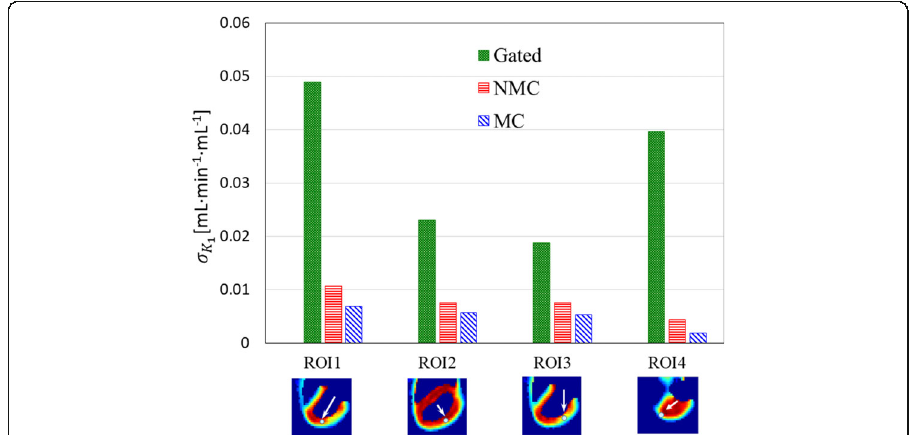
Fig. 8 Standard deviation of K 1 values estimated from 25 noise realizations. Each white arrow together with a small circle were only used to indicate the approximate location of the ROI. Please see the text in the “ Methods ” section for the details on how the ROIs were